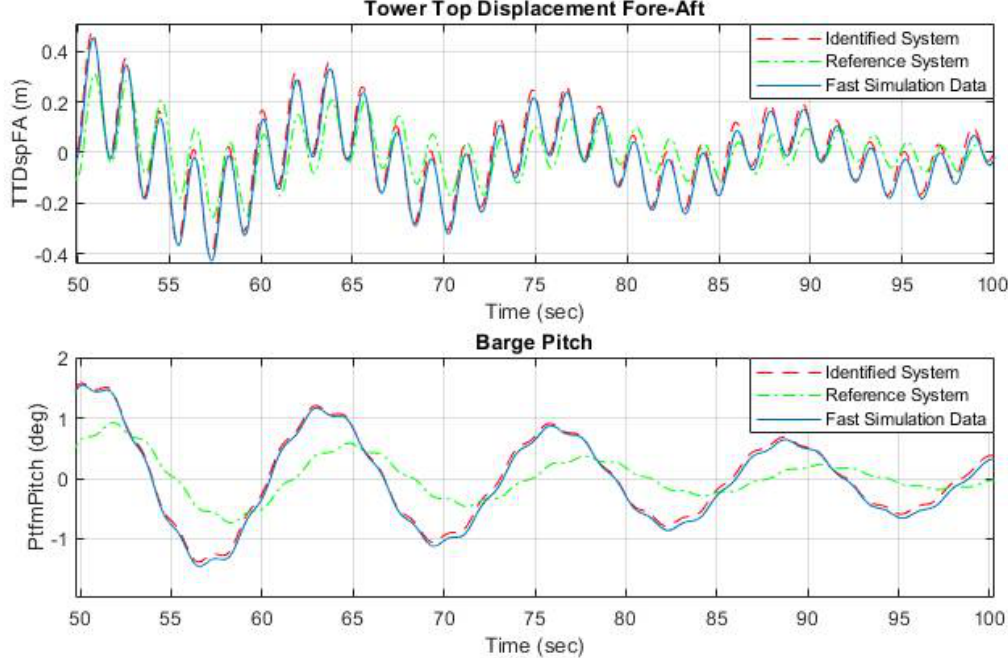
Figure 5. Comparison of the identified model (dashed red), the reference model (dot-dashed green), and FAST-SC (solid blue).